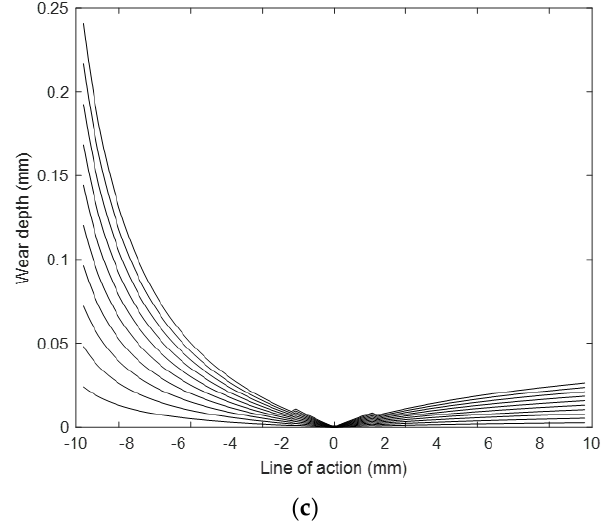
Figure 6. Wear depth variations through tooth profile of plastic gears ( a ) ABS, ( b ) PLA, and ( c )PETG.